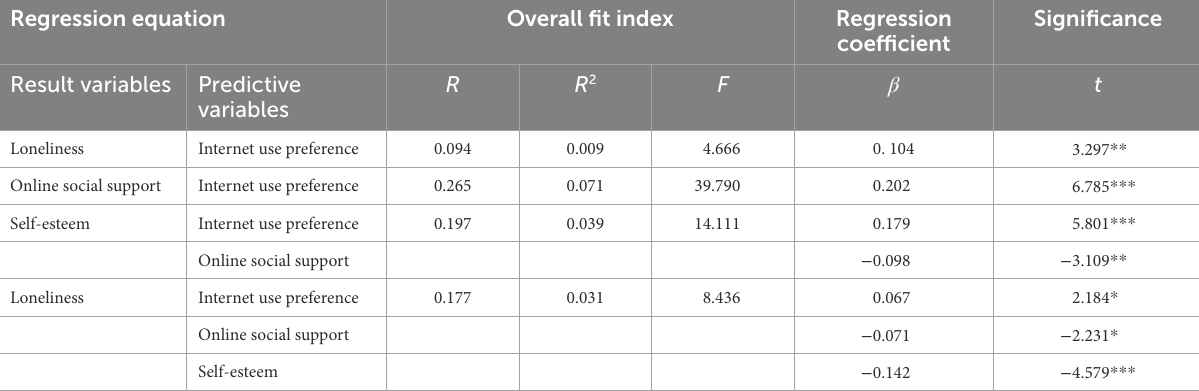
TABLE 2 Regression analysis on the relationships between variables. Regression